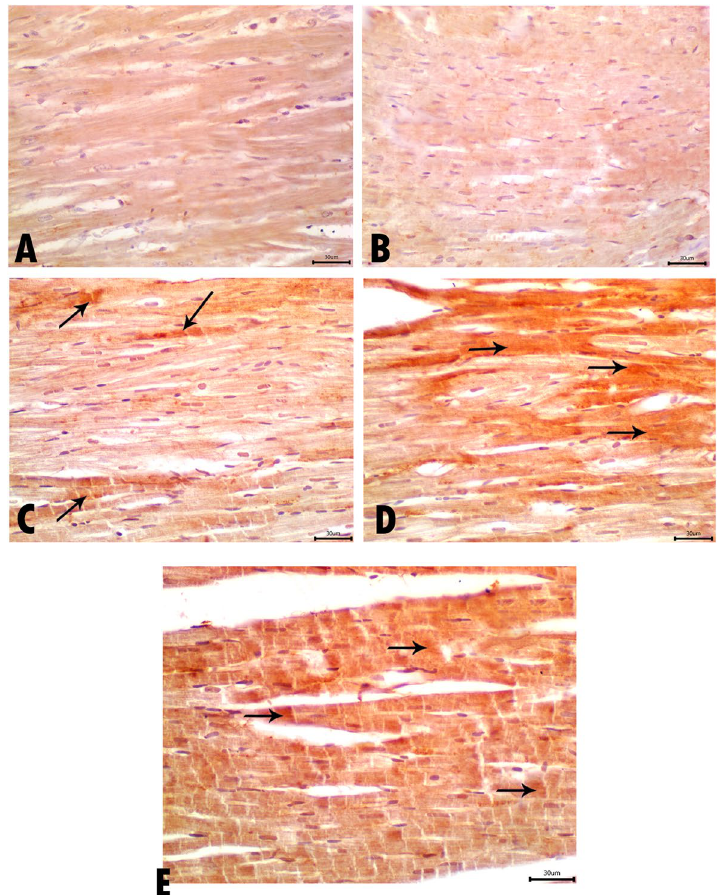
Fig. 13 Photomicrographs of sections in the heart immunohistochemically stained with cannabinoid receptor 1 (CB1) ( and positive control groups show weak positive reactions in the cytoplasm of cardiomyocytes. C The acute treated group shows an increase in positive immune reaction in cardiomyocytes (arrows). D and E Chronic treated and chronic withdrawal groups reveal an increased positive reaction in cardiomyocytes